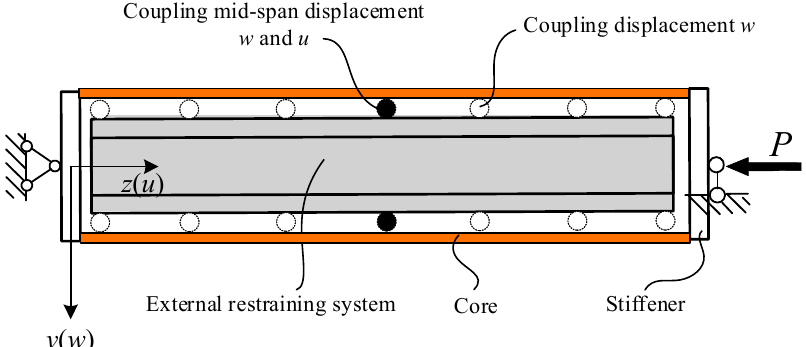
Figure 4. Lateral displacement coupling between the core and the restrained system.